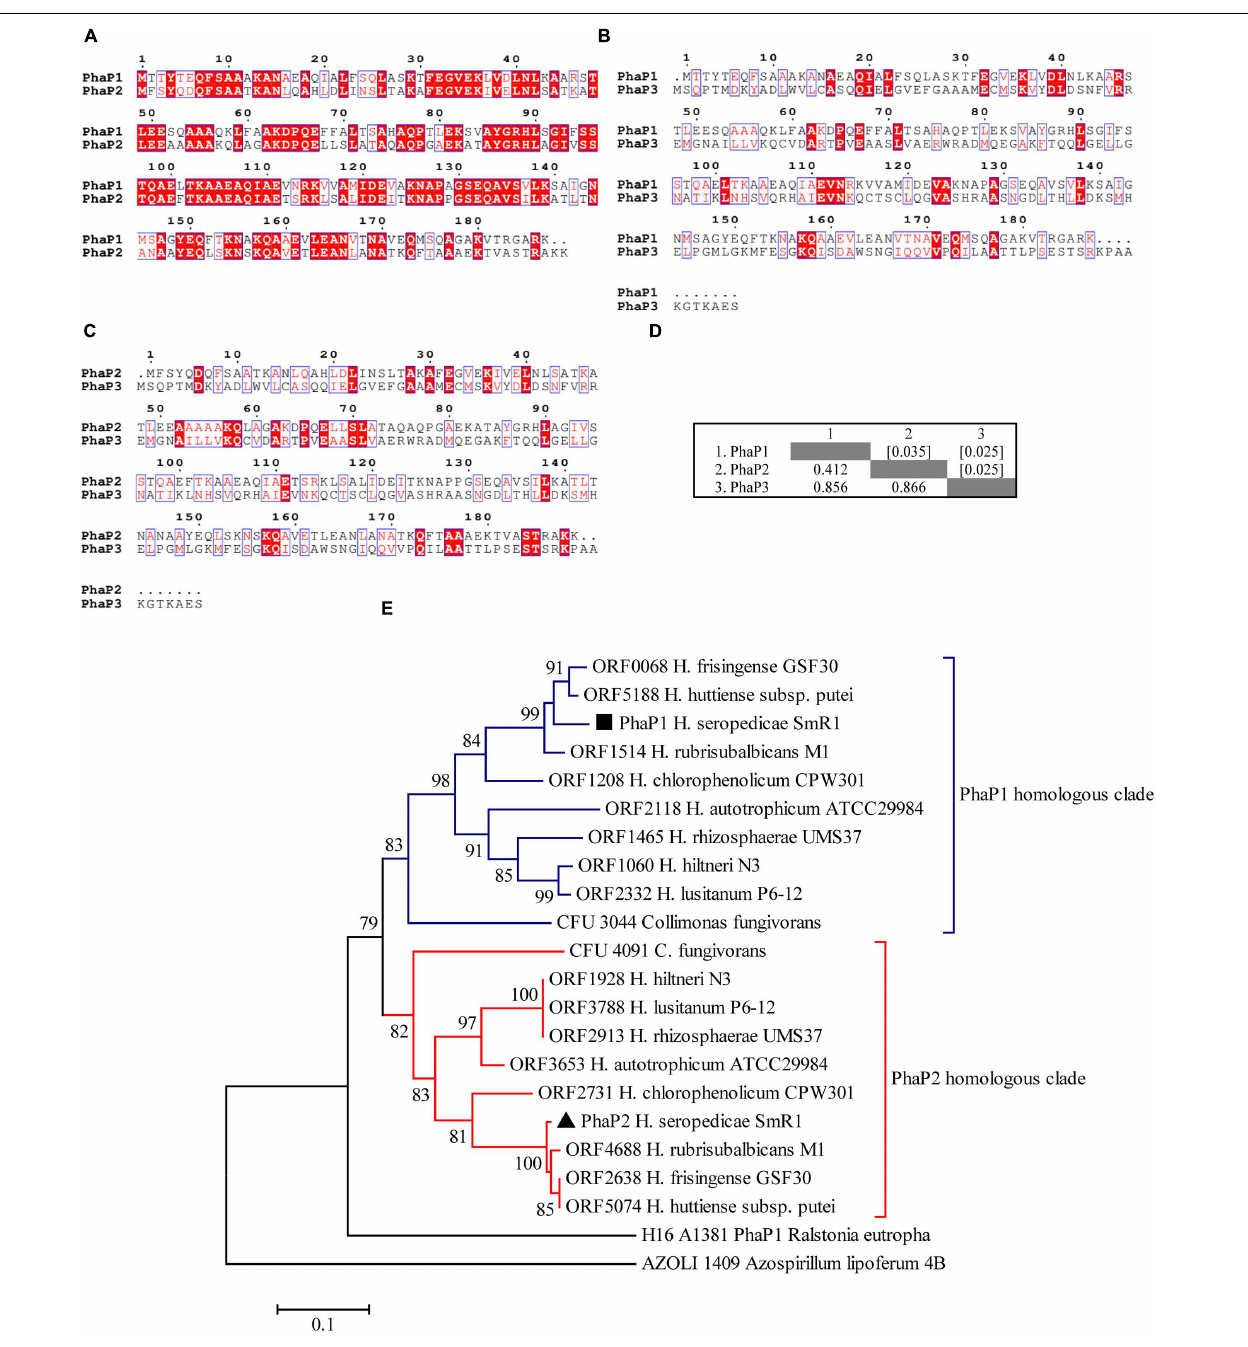
FIGURE 1 | Protein sequence alignments of phasins from Herbaspirillum seropedicae SmR1 and phylogenetic analysis of homologous sequences. Multiple alignments of protein sequences of (A) PhaP1 (Hsero_1639) and PhaP2 (Hsero_4759), (B) PhaP1 and PhaP3 (Hsero_2402), and (C) PhaP2 and PhaP3 were carried out using Espript 3.0 and the default parameters (Robert and Gouet, 2014). The red shaded letters indicate identical residues, while red letters represent conserved residues. (D) The number of amino acid differences per site from between PhaP1, PhaP2, and PhaP3 sequences are shown. Standard error estimate(s) are shown above the diagonal (enclosed within brackets) and were obtained by a bootstrap procedure (10000 replicates). All ambiguous positions were removed for each sequence pair. There were a total of 199 positions in the final dataset. Evolutionary analyses were conducted in MEGA6 (Tamura et al., 2013). (E) The evolutionary history was inferred using the Neighbor-Joining method (Saitou and Nei, 1987). The putative phasin of Azospirillum lipoferum encoded by the AZOLI 1409 (Wisniewski-Dye et al., 2011) was applied as an outgroup. Only nodes with bootstrap test (10000 replicates) bigger than 70% are shown next to the branches (Efron et al., 1996). The tree is drawn to scale, with branch lengths in the same units as those of the evolutionary distances used to infer the phylogenetic tree. The evolutionary distances were computed using the p -distance method and are in the units of the number of amino acid differences per site. Evolutionary analyses were conducted in MEGA6 (Tamura et al., 2013). The PhaP sequences used to construct the tree are shown in Supplementary Figure S1.